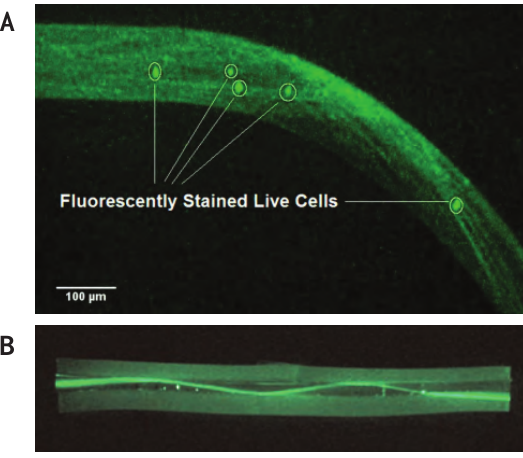
Fig. 6. Hydrogel waveguides. (A) Live cells encapsulated in an agarose hydrogel waveguide. Reprinted by permission from [137], Copyright 2012, The Optical Society. (B) Light guiding in core- cladding hydrogel waveguide. Reprinted by permission from [138], Copyright 2009, Wiley.